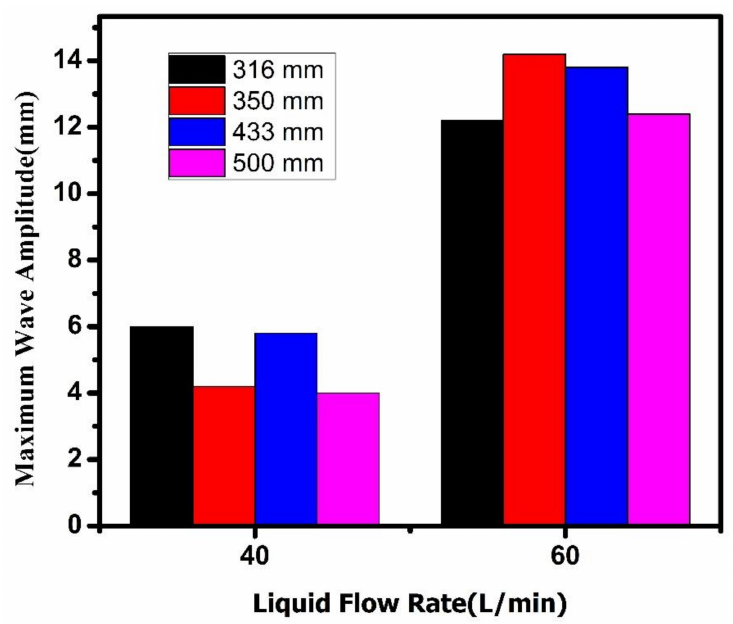
Figure 9. Effect of section sizes (mould width) on maximum surface wave amplitude for 15 ◦ upward port under different operating